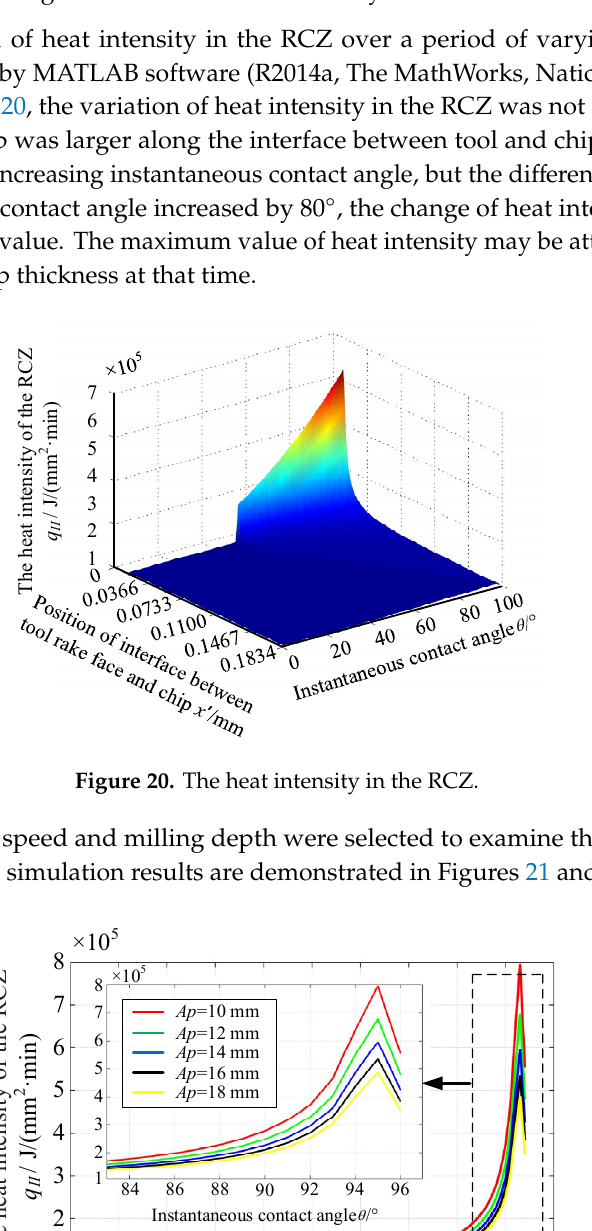
Figure 22. The heat intensity in the RCZ at different milling depths ( V = 40 m/min). As shown in Figure 21 and 22, when milling depth remained unchanged and milling speed increased, the heat intensity in the RCZ was enhanced, and the enhancement rate was most significant when the undeformed chip thickness reached a maximum value. When the contact angle was 93°, the undeformed chip thickness nearly reached the maximum value, meanwhile, milling force also nearly reached the maximum value. In contrast, when milling speed remained unchanged and milling depth increased, the heat intensity in the second deformation zone was reduced. Similarly, when the undeformed chip thickness reached its maximum value, the weakening rate of heat intensity was found to be most significant. 3.3. Analysis of Heat Distribution Ratio and Heat Intensity in the FWZ 3.3.1. The Influence of Milling Parameters on Heat Distribution Ratio in the FWZ The changes in heat distribution ratios of the heat source in the FWZ to the wear band on the flank of end mills over a period of change of varying undeformed chip thickness were simulated by MATLAB software (R2014a, The MathWorks, Natick, MA, the United States, 2014). As shown in Figure 23, the heat distribution ratios between the heat source in the FWZ and wear band on the flank of end mills varied from 0.3726 to 0.378 over the period of varying undeformed chip thickness. The results demonstrated that heat distribution ratios were positively correlated with the changes in undeformed chip thickness, which may be due to the effect of undeformed chip thickness on milling force.